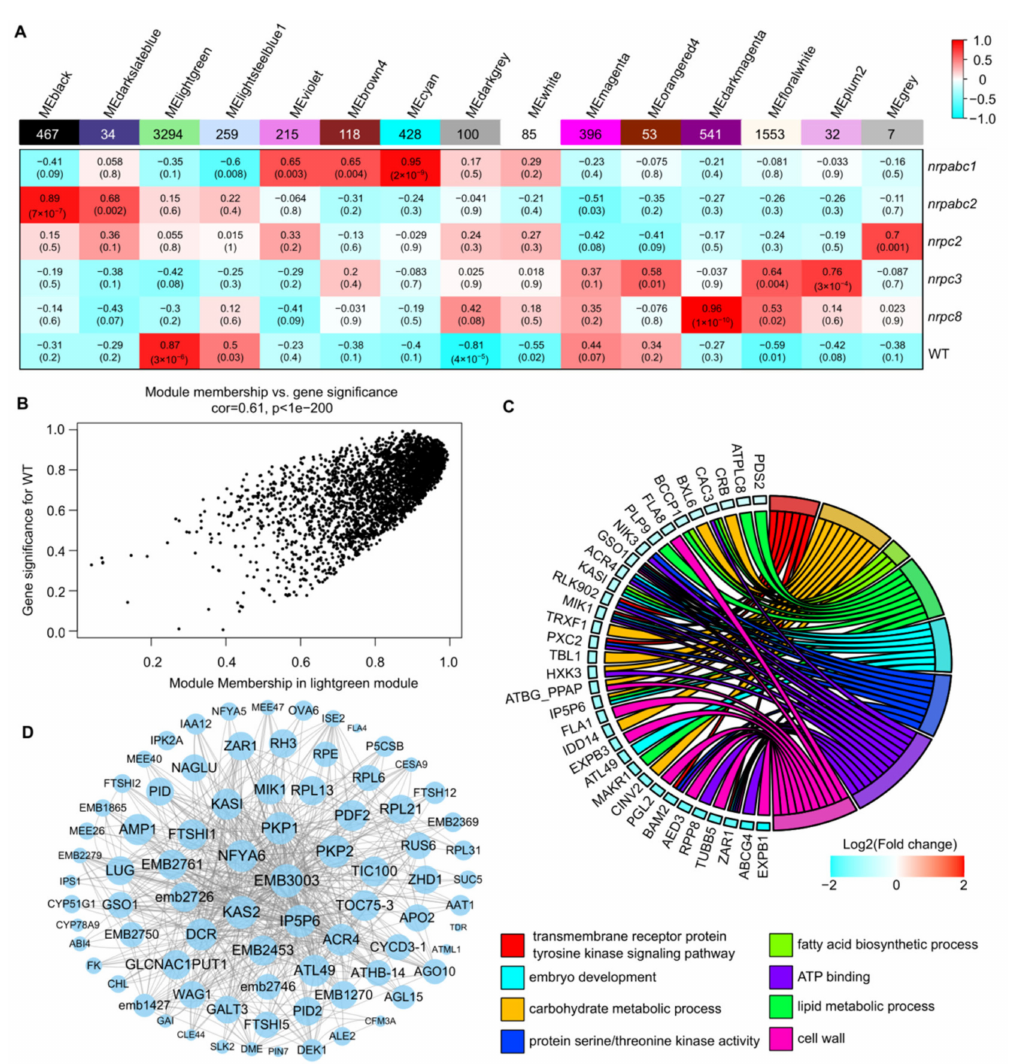
Figure 6. WGCNA of the transcripts in wild-type and different subunit knockdown lines. ( A ) Association between modules and traits. The legend indicates the correlation. Each cell shows the number of corresponding correlations and the p -values. ( B ) Module membership versus gene significance in the MElightgreen module. ( C ) GO classification of hub genes in the MElightgreen module. ( D ) Network analysis of the proteins related to seed development or embryo development in the MElightgreen